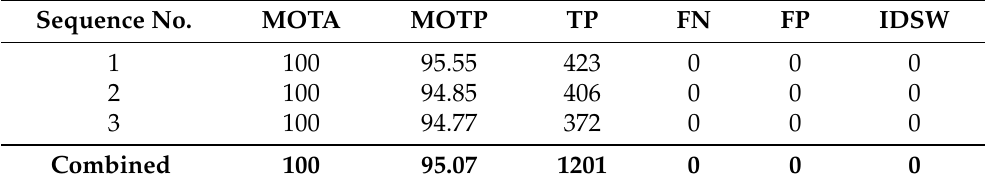
Table 2. Scenario 1—category 1 Quantitative results of the tracker’s performance to track objects of category 1 (large vessel) in scenario 1. Scenario 1 consists of three sequences involving both moving and static objects, and no occlusion or dynamic movement of the camera is applied.